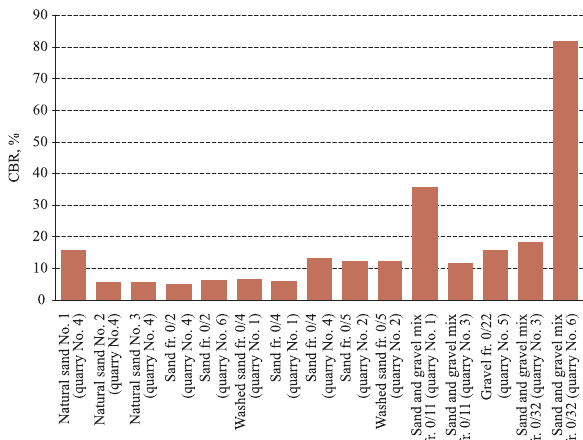
Fig. 3. The values of California Bearing Ratio